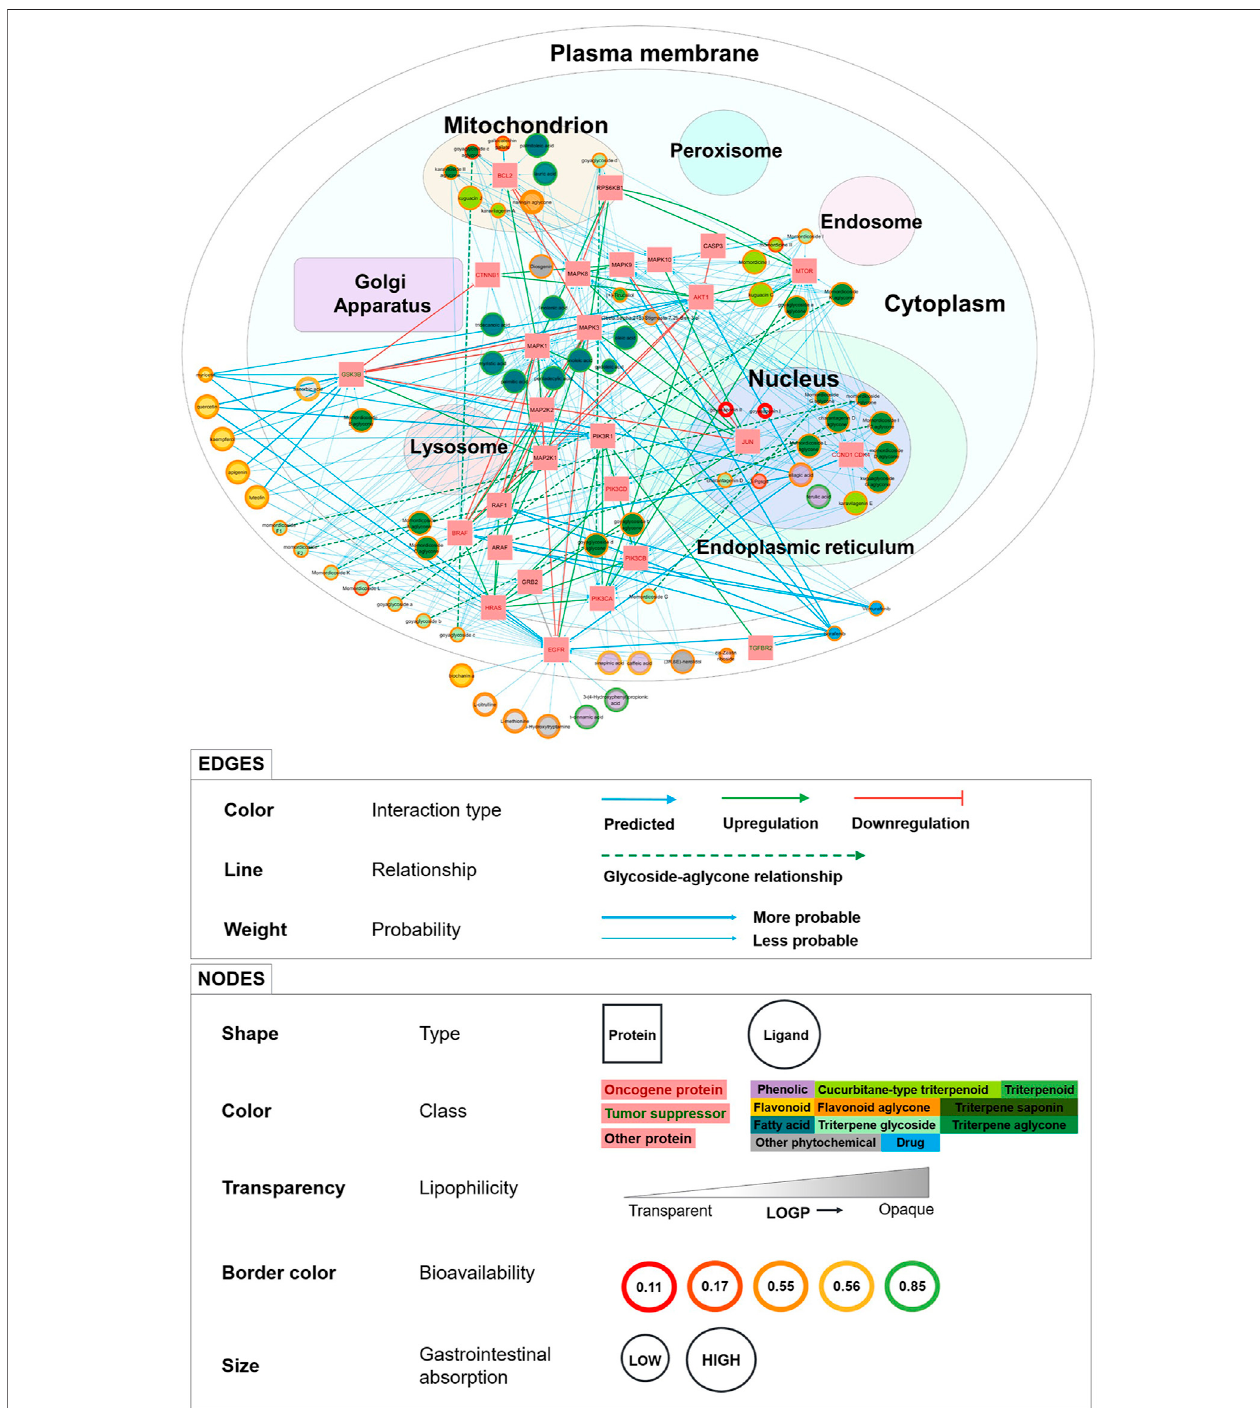
FIGURE 2 | PCPI-SIGNOR disease network visualization for bitter gourd against colorectal cancer. The cell template is from the Cytoscape plug-in boundaryLayout. Detailed legend at the bottom. The network can be interactively viewed at https://yumibriones.github.io/network/.